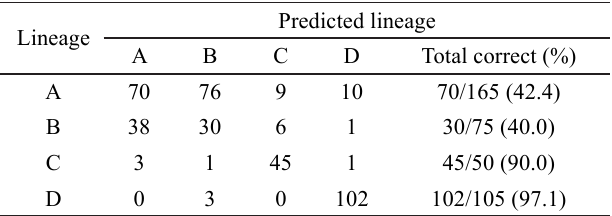
Table 3. Classification of predicted lineage for lineages A, B, C and D of Cardiocondyla sl. kagutsuchi workers in Japan using discrimi- nant analysis (DA). Numerical values are the number of individuals that DA classified into each of the four lineages.